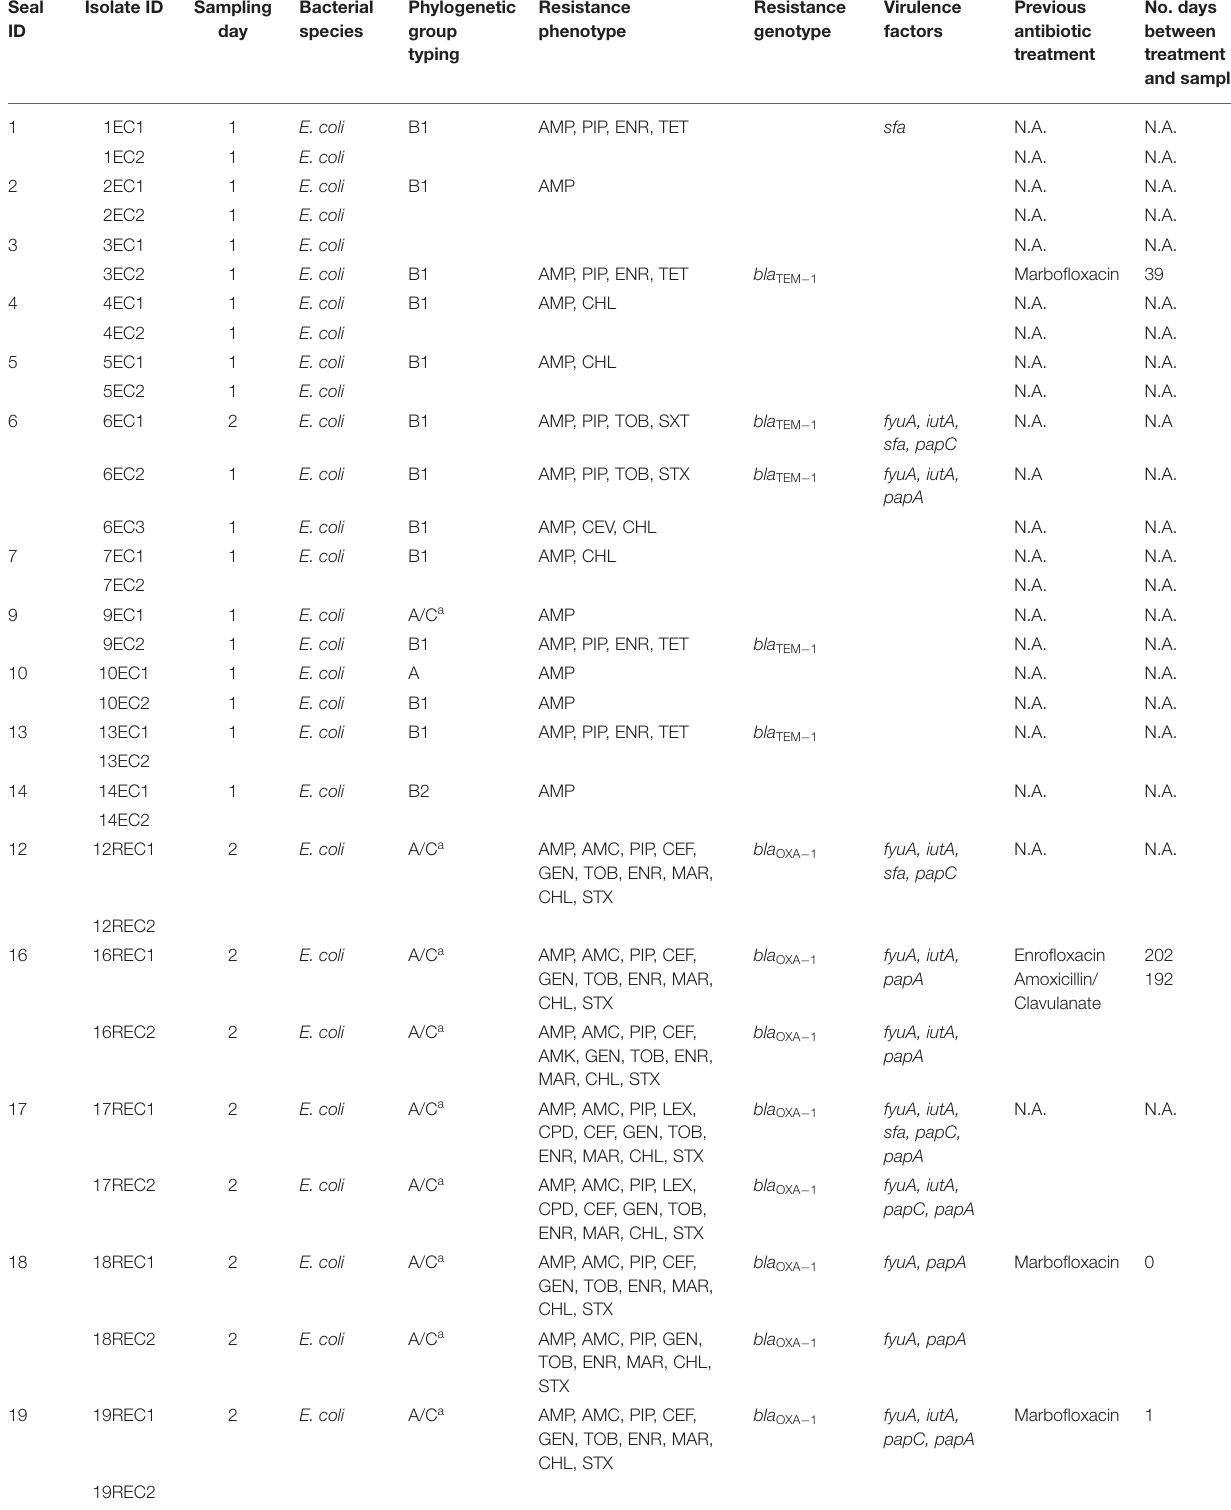
TABLE 1 | Sampling details including animal identification, sampling day and bacteria isolated from faeces; E. coli isolated from TBX supplemented with cefotaxime (REC), E. coli isolated from TBX (EC) and non- E. coli isolated from TBX supplemented with cefotaxime (RC) according to sampling-day (3rd of July and 25th of July). Seal